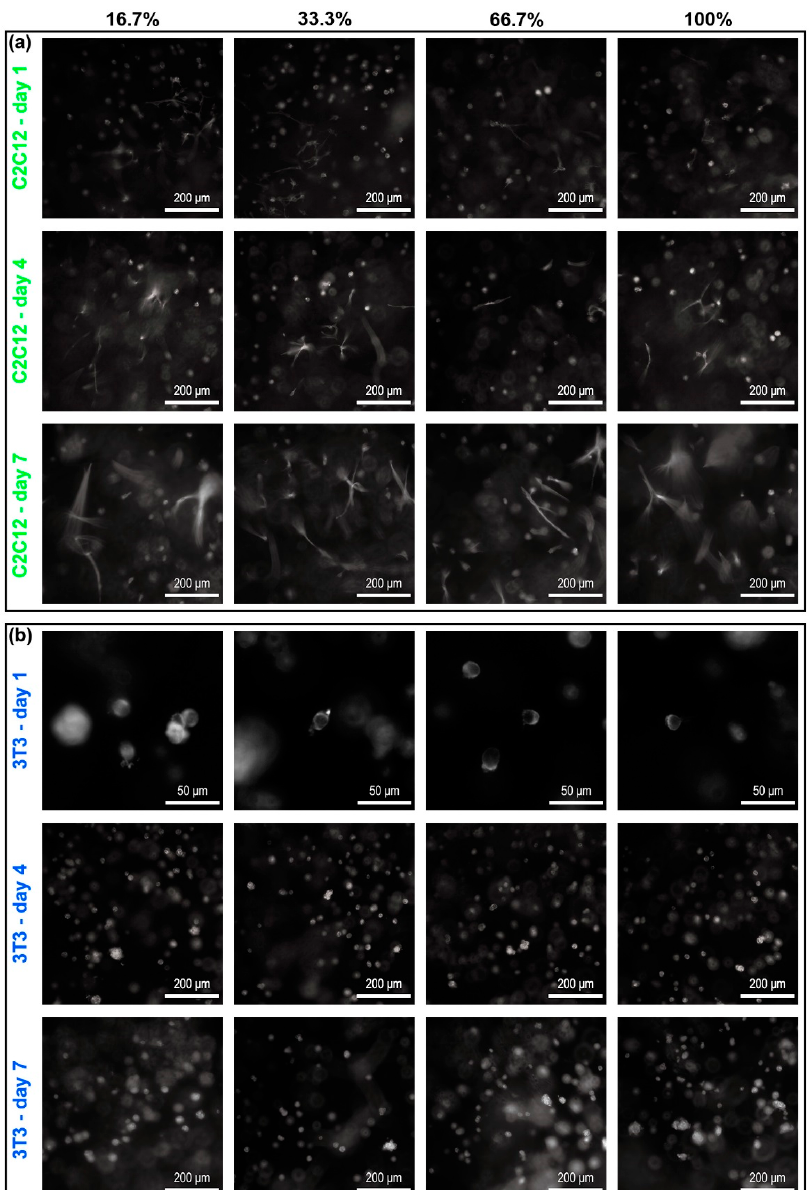
Figure 10. The impact of four different RGD clustering cases on the morphology of F-actin in cells over time. The main parameters of dextran hydrogel were crosslinking strength = 2 mM and RGD = 50 µM. ( a ) Morphology of F-actin in C2C12 cells; ( b ) Morphology of F-actin in 3T3 cells; Cells were observed by an inverted microscope, and the images were taken with a digital sCMOS camera. The proportions of the mal-dextran reacted with RGD for four cases are 16.7%, 33.3%, 66.7%, and 100%, respectively.